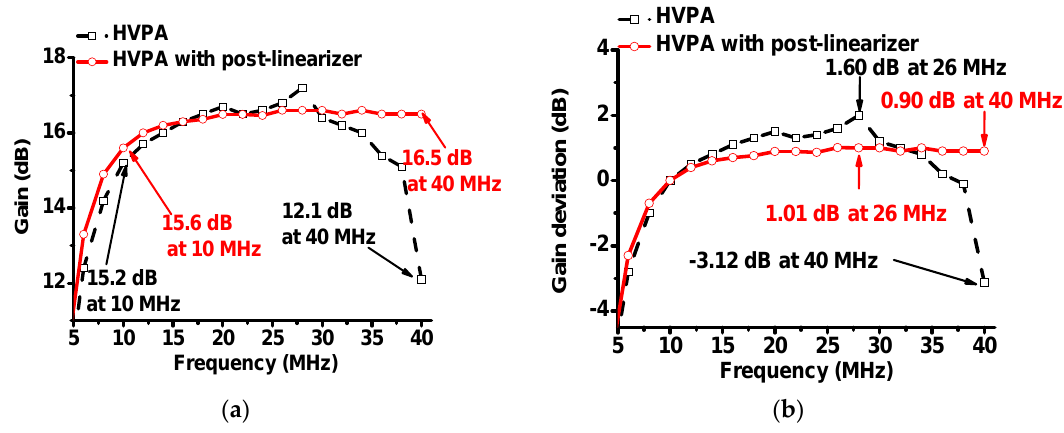
Figure 8. ( a ) Gain vs. frequency and ( b ) gain deviation vs. frequency of the HVPA without the post ‐ Figure 8. ( a )Gainvs. frequencyand( b )gaindeviationvs. frequencyoftheHVPAwithoutthe post-linearizer linearizer (black ‐ dashed line) and HVPA with post ‐ linearizer when 17 dB m input power was applied. (black-dashed line) and HVPA with post-linearizer when 17 dB m input power was